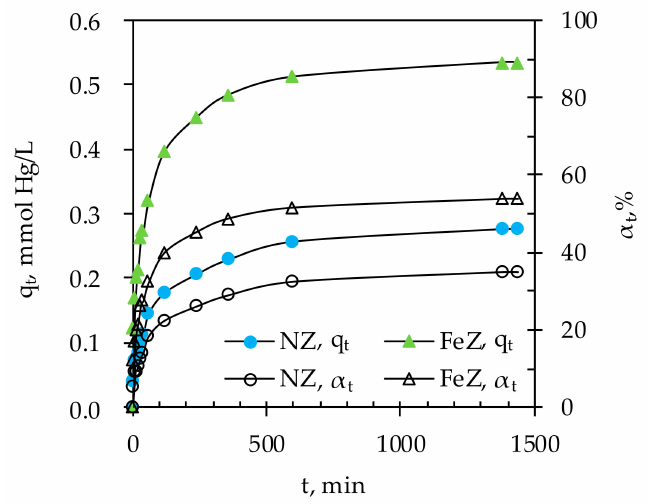
Figure 5. The amount of Hg(II) sorbed on NZ and FeZ as well as the removal e ffi ciency in relation to contact